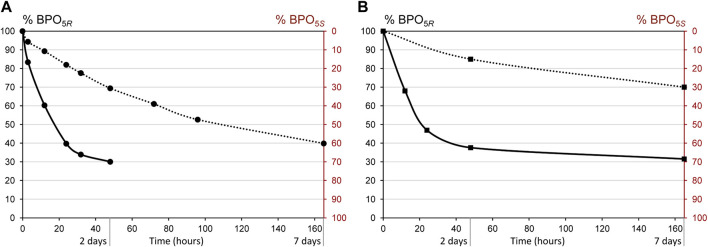
Stability of BPO in (A) PBS/D2O, pD∼7.4 and (B) D2O, pD = 6, at 23°C (solid line) and 4°C (dotted line).